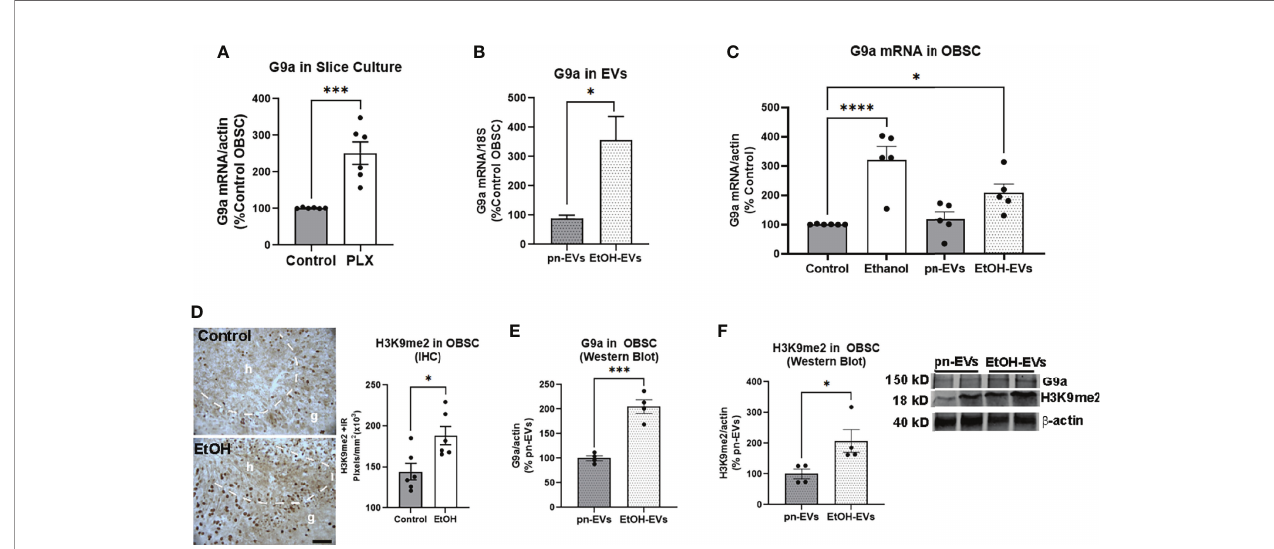
FIGURE 5 | Microglia depletion and ethanol-EVs increase G9a in OBSC. (A) G9a mRNA was measured in control or PLX-microglial depleted OBSC. PLX resulted in a 2.5-fold increase in G9a relative to controls. N = 6 experimental replicates. ***p < 0.001, t- test (B) EVs were isolated from OBSC media after either ethanol (EtOH-EVs) or vehicle control (pn-EVs). RT-PCR of mRNA isolated from EVs found a 3.5-fold increase of G9a mRNA in EtOH-EVs. N = 2 experimental replicates/group. (C) G9a mRNA was increased in OBSC slice tissue after treatment with either ethanol (3-fold) or EtOH-EVs (2-fold). * p < 0.05, ****p < 0.0001, Sidak ’ s post-test. (D) IHC found EtOH increased the number of H3K9me2 immunoreactive (+IR) pixels/mm 2 in the dentate granular (g) cell region of OBSC by 30%. The dashed white line marks the border of the hilus (h), which is the neurogenic region. Each dot represents an OBSC slice. *p < 0.05, t- test Scale bar 100 µm. (E, F) OBSCs were treated with either control (pn- EVs) or EtOH-EVs. Western blot found that EtOH EVs increased of levels of (E) G9a protein (2-fold) and (F) H3K9me2 (2.1-fold). Each dot represents 4-6 pool OBSC slices. *p < 0.05, *** p < 0.001, t- test. Insert with representative western blot images of G9a, H3K9me2 and